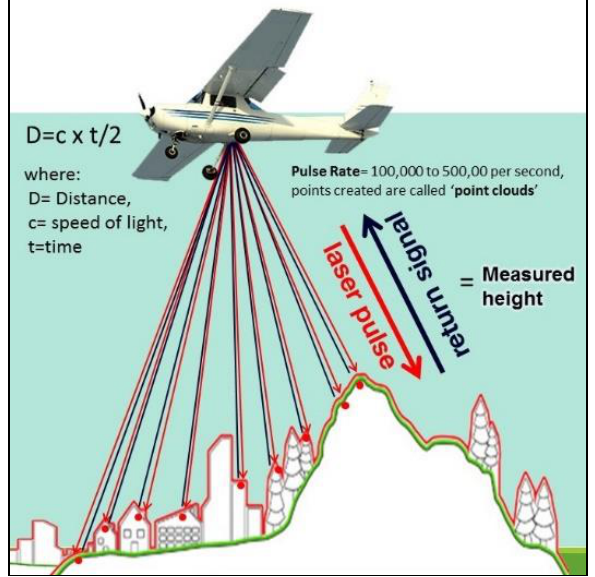
Figure 3. Airborne LiDAR data